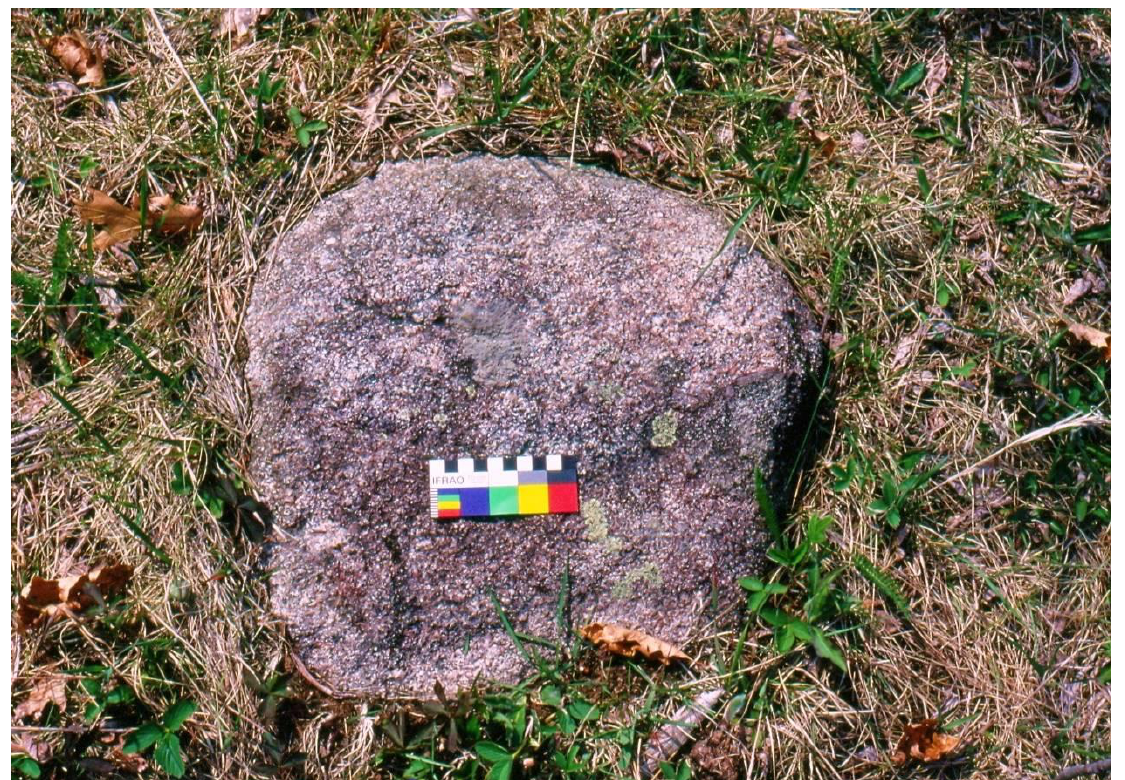
Figure 11. Photo of the extremely weathered and deeply embedded, reddish cast (granodiorite) rock placed to represent the bright, red star Aldebaran (Figure 2).